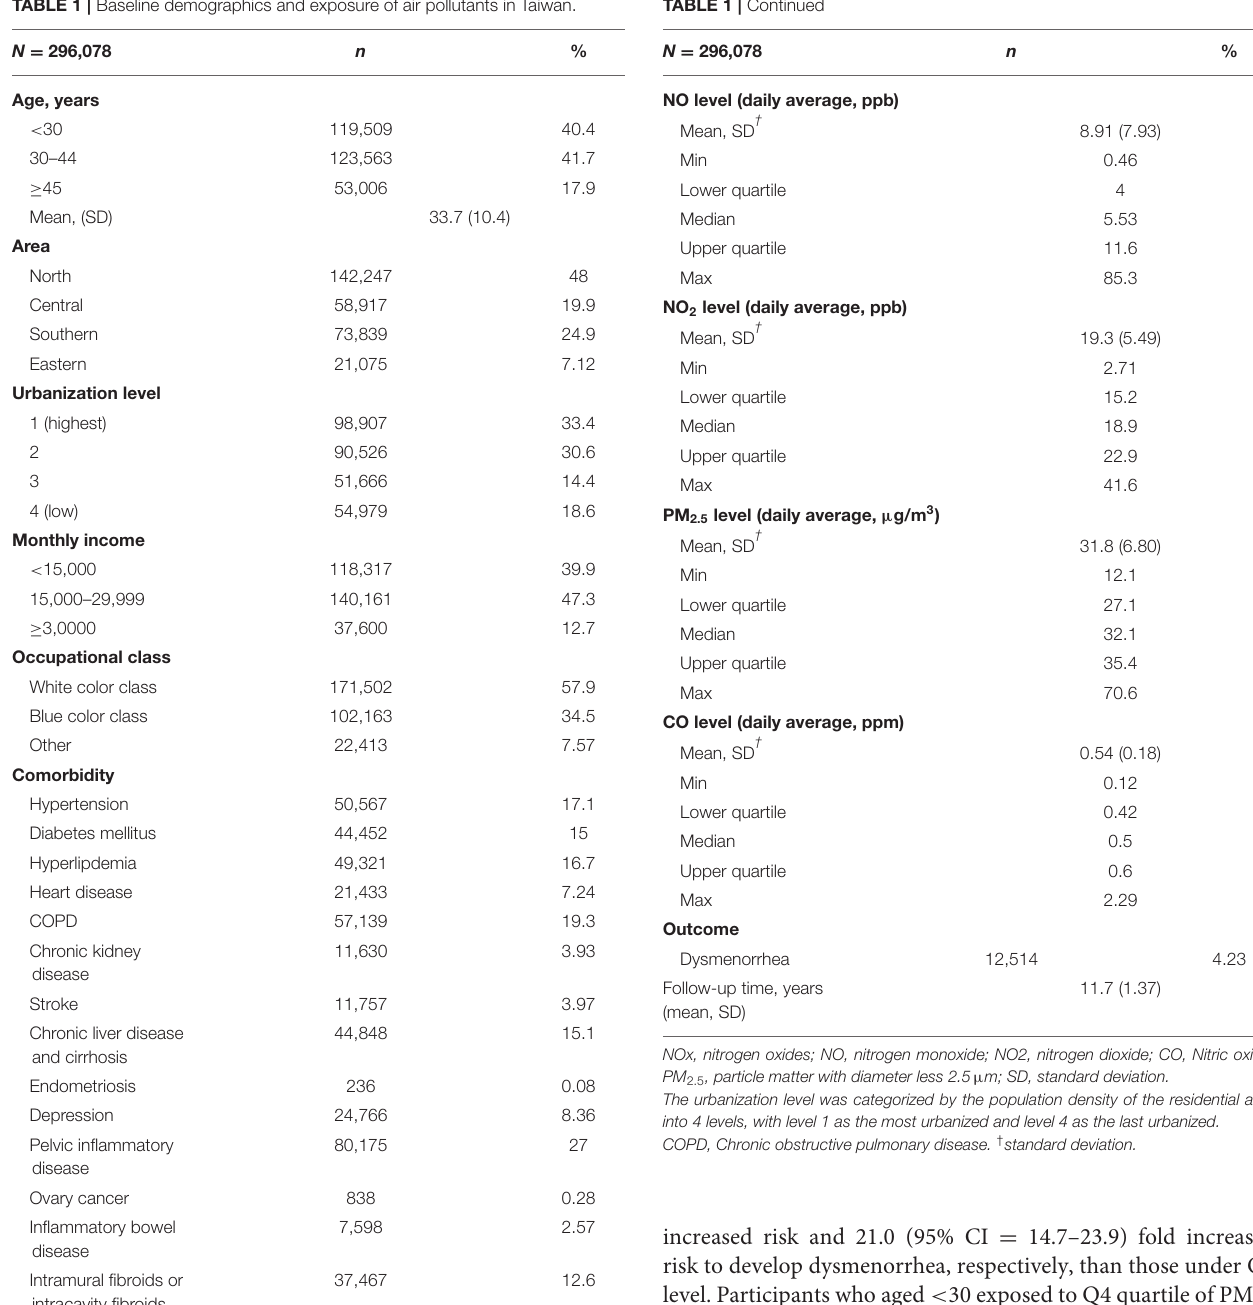
TABLE 1 | Baseline demographics and exposure of air pollutants in